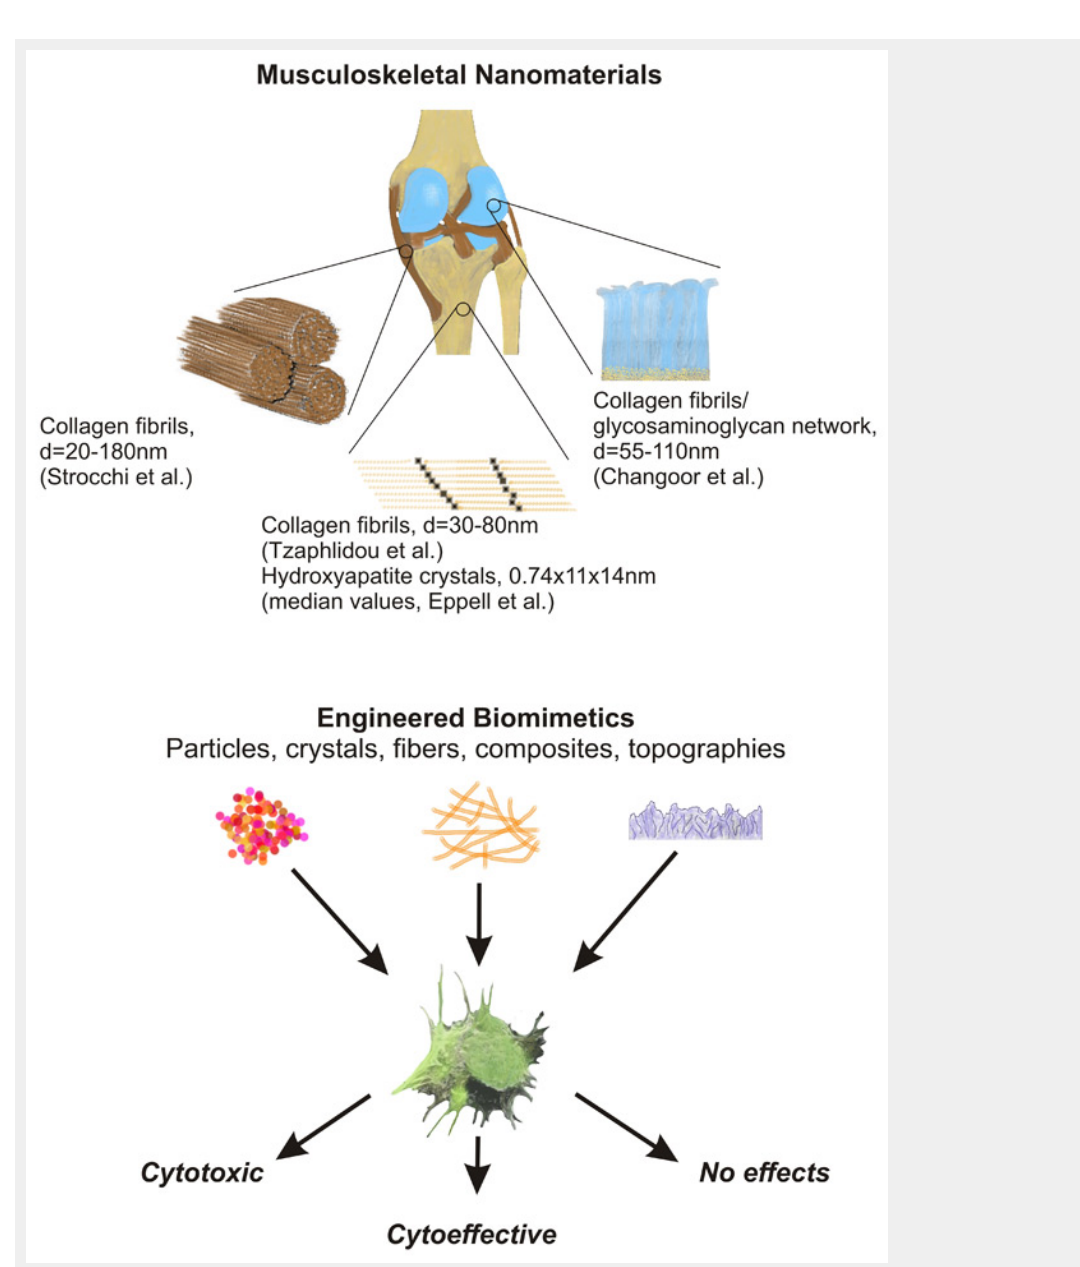
Musculoskeletal tissues – the prototypes of nanomaterials. The structural composition of ligaments/ tendons, bone and cartilage is very similar, although these tissues have quite a distinct appearance. In a simplified approach they consist of a characteristic network of collagen fibrils with diameters of approximately 100 nm embedded within a tissue specific matrix. Appropriate engineering of nanobiomaterials making use of particles, crystals, fibres, composites or surface topographies may lead to biomimetic constructs that exhibit a favourable inductive interplay with the host cells and tissues. Detailed and standardised investigations are necessary to predict the cellular and organ reaction upon exposition to those nanomaterials. (References: Strocchi R et al. Ital J Anat Embryol. 1996;101(4):213–20. Changoor A et al. Osteoarthritis Cartilage. 2011;19(12):1458–68. Tzaphlidou M et al. Micron. 2005;36:593–601. Eppell S et al. J Orthop Res.